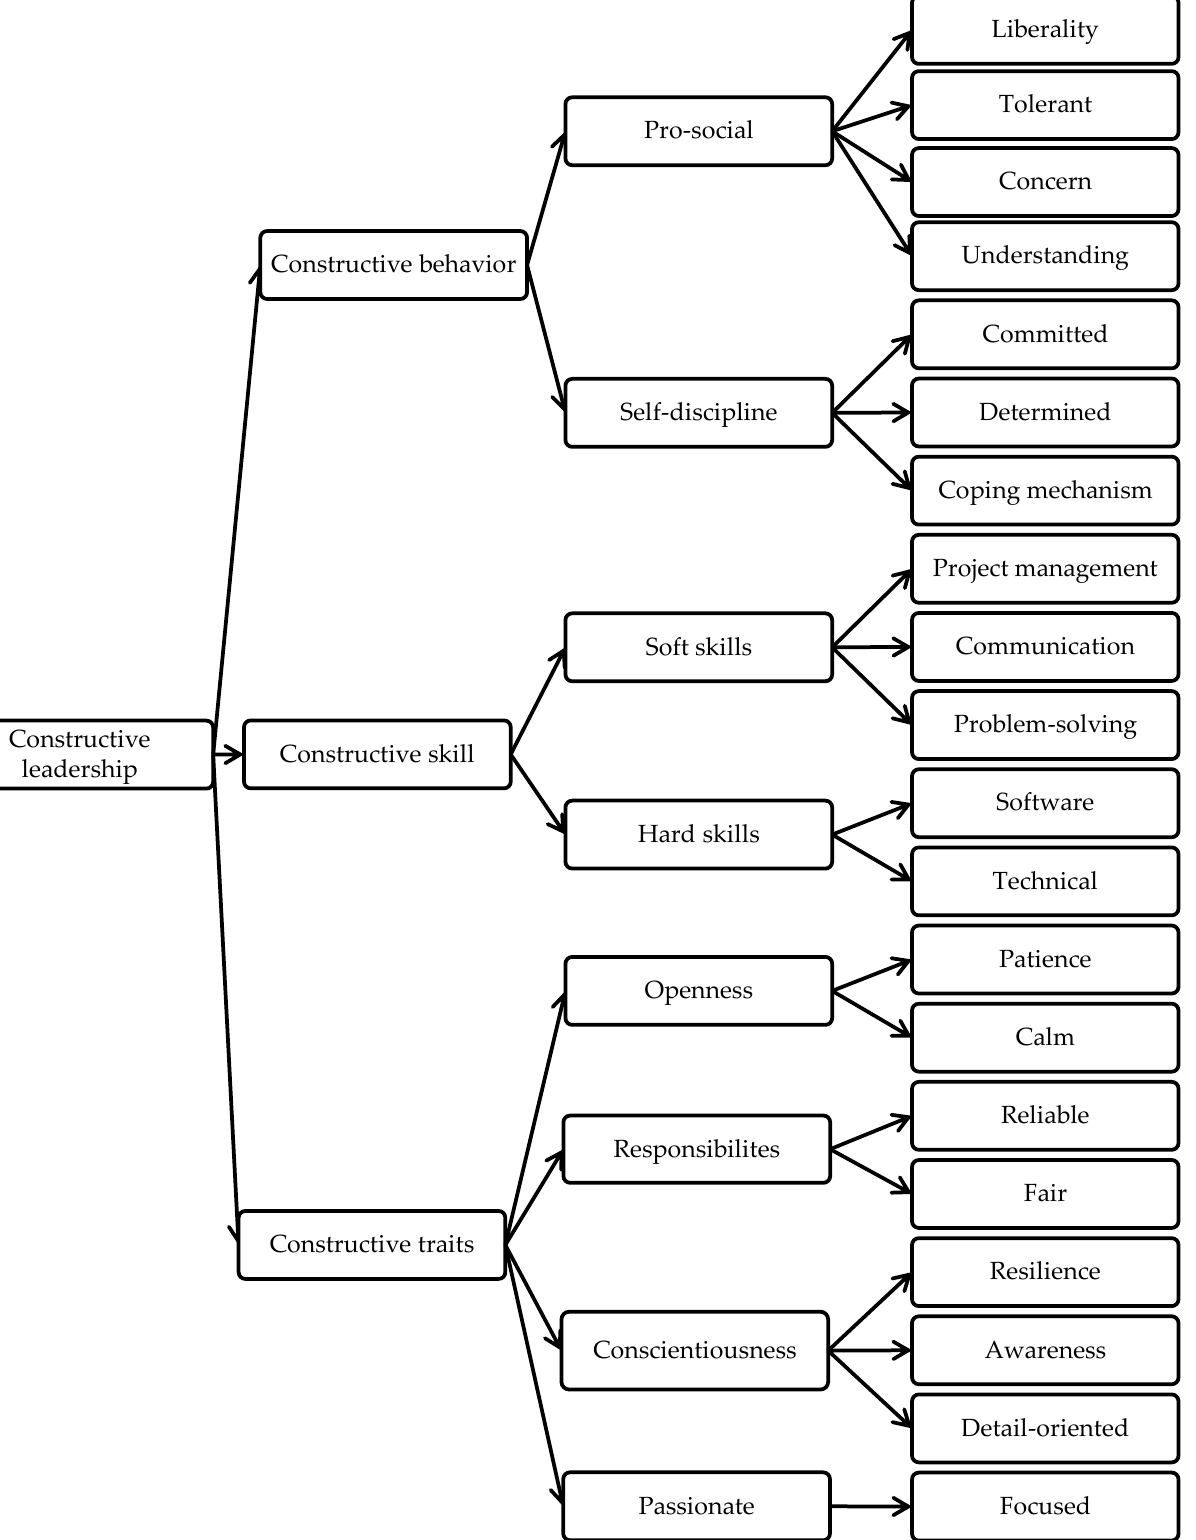
Figure 2. Constructive leadership behaviors, skills, and traits in BIM-based construction projects.